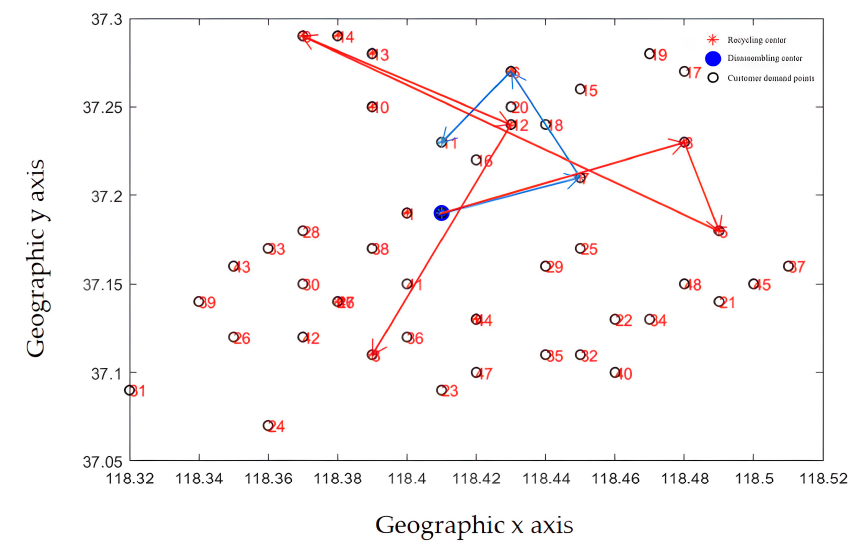
Figure 14. Delivery route before optimization (classic NSGA-II algorithm).